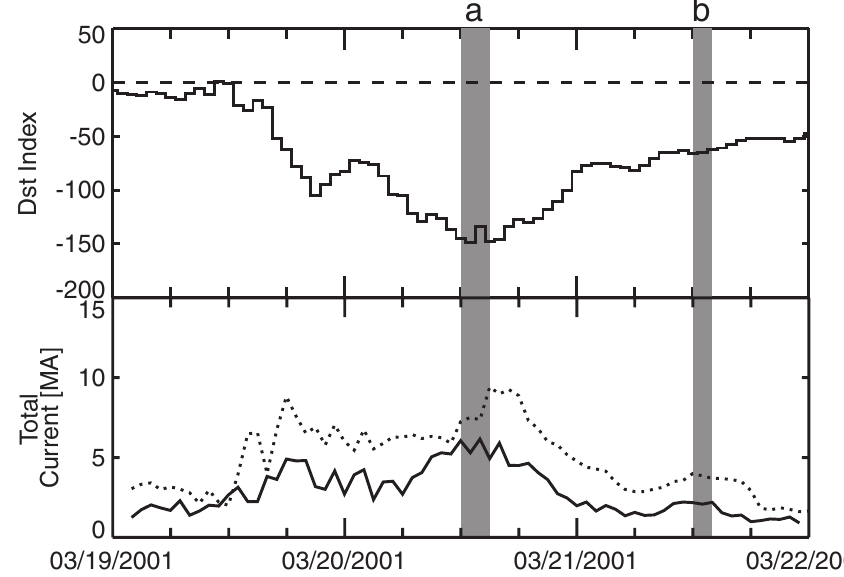
Fig. 8. D st Index and total currents from Iridium (solid line) and LFM (dotted line) for the 19–21 March 2001 magnetic cloud. The intervals shown in Fig. 5 are gray